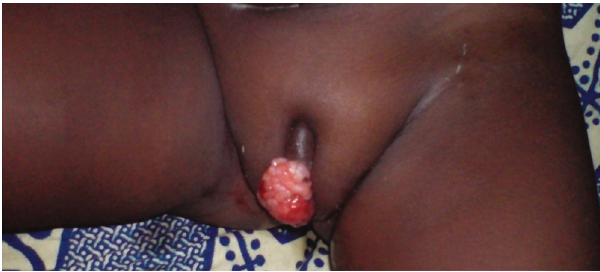
Figure 3: Macroscopical view of clitoris features after chemotherapy